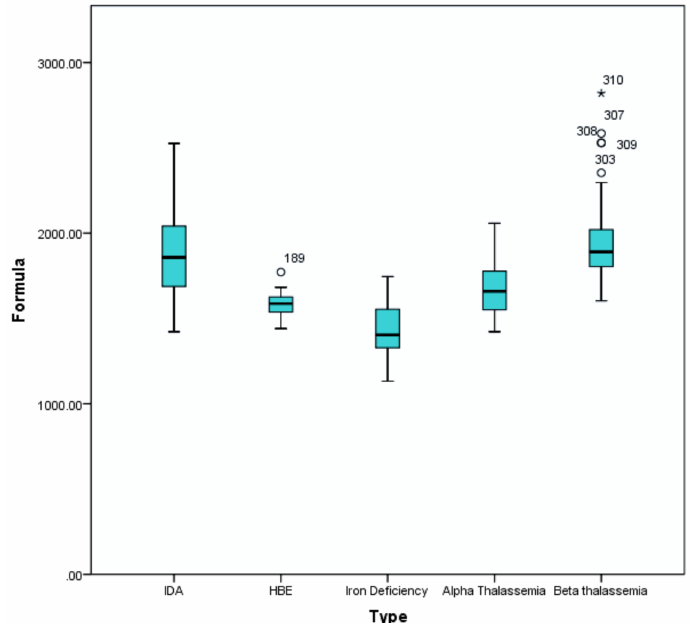
Figure 5. Box and whisker plot for the αβ -algorithm in various red cell disorders (IDA, HbE trait (labelled as HBE in this figure), iron deficiency, α thalassaemia trait (labelled as alpha thalassemia), and β -thalassaemia trait (labelled as beta-thalassemia). Outliers are marked as “*” and “ 0 ” in the HbE trait and β -thalassaemia trait groups.